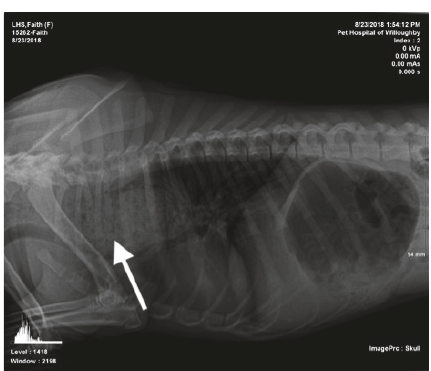
Figure 1: Referral right lateral thoracic radiograph showing cranial esophageal dilation with food (white arrow).